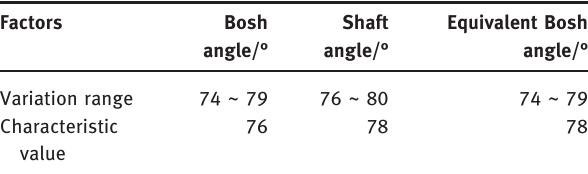
Table 4: Influence factors and their value level.